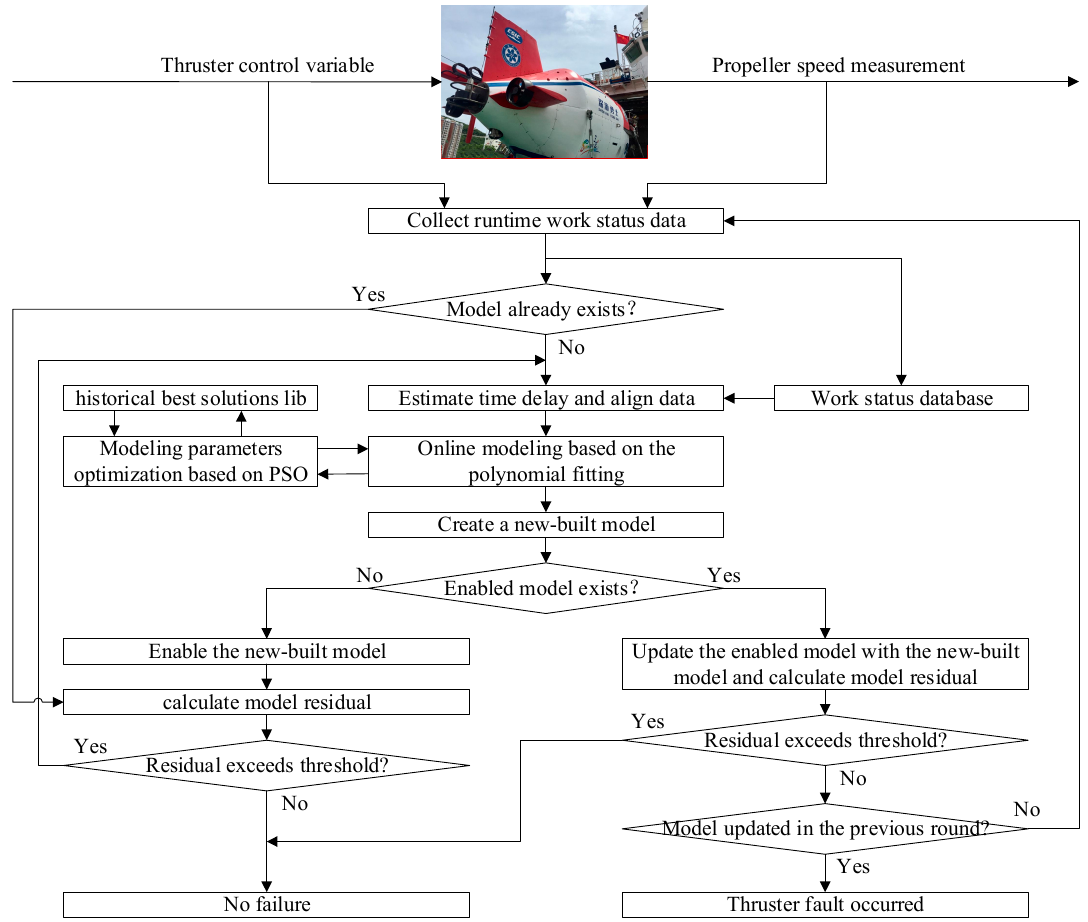
Figure 6. The schematic flowchart of the thruster fault detection algorithm.